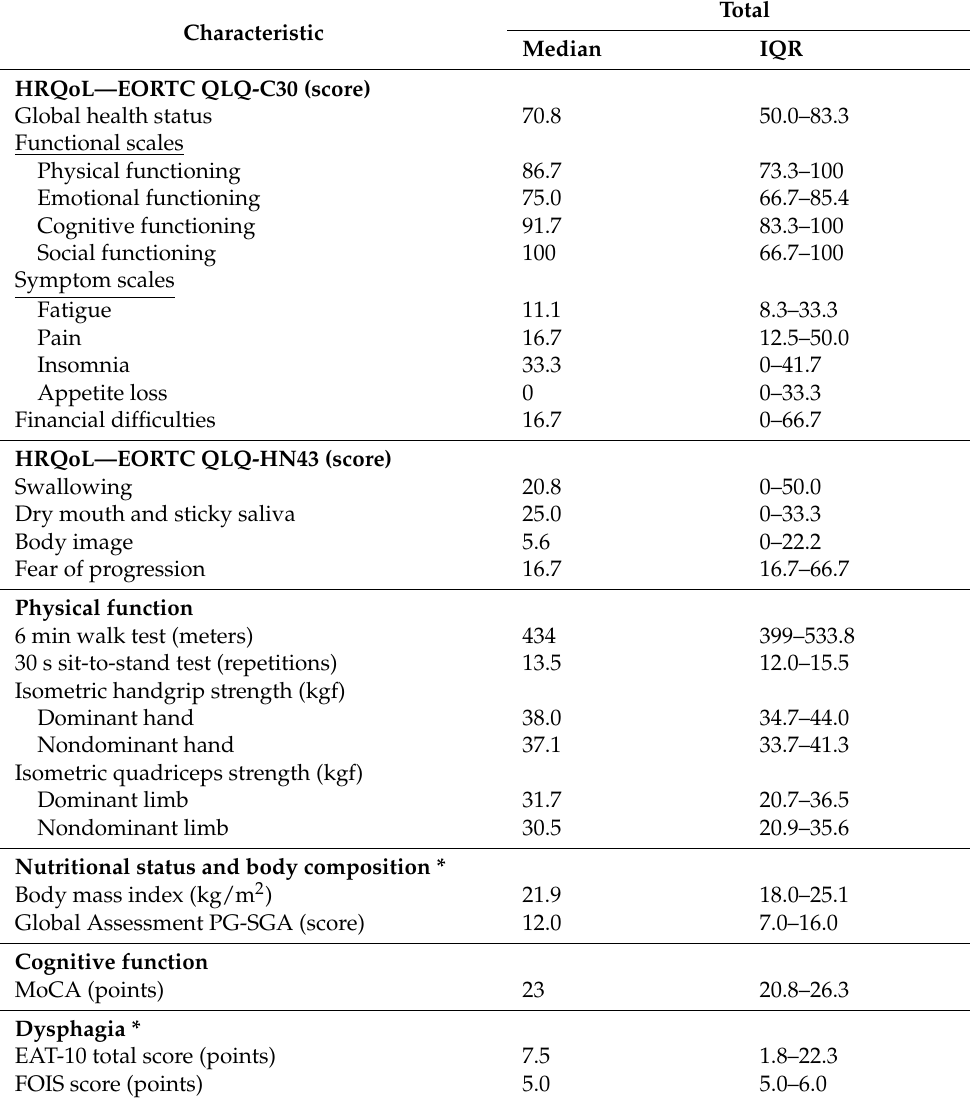
Table 2. Baseline quality of life, physical fitness, dysphagia, nutritional status, and cognitive function (n =